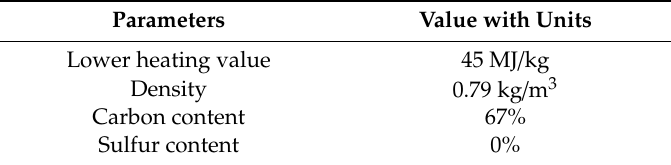
Table 4. Properties of the natural gas fuel used in a natural gas power generator.